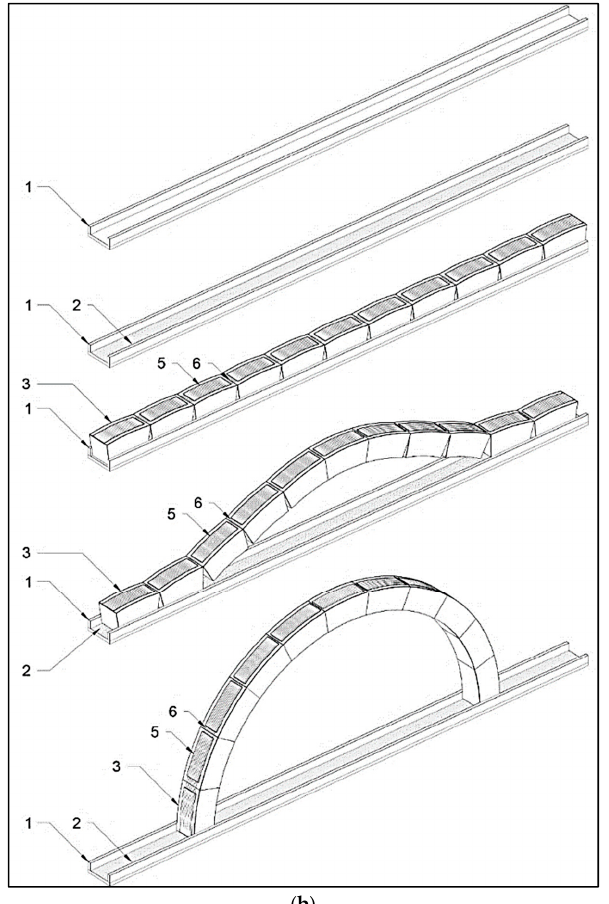
Figure 1. A description of the proposed technology, with hinge achievement ( a ) and construction